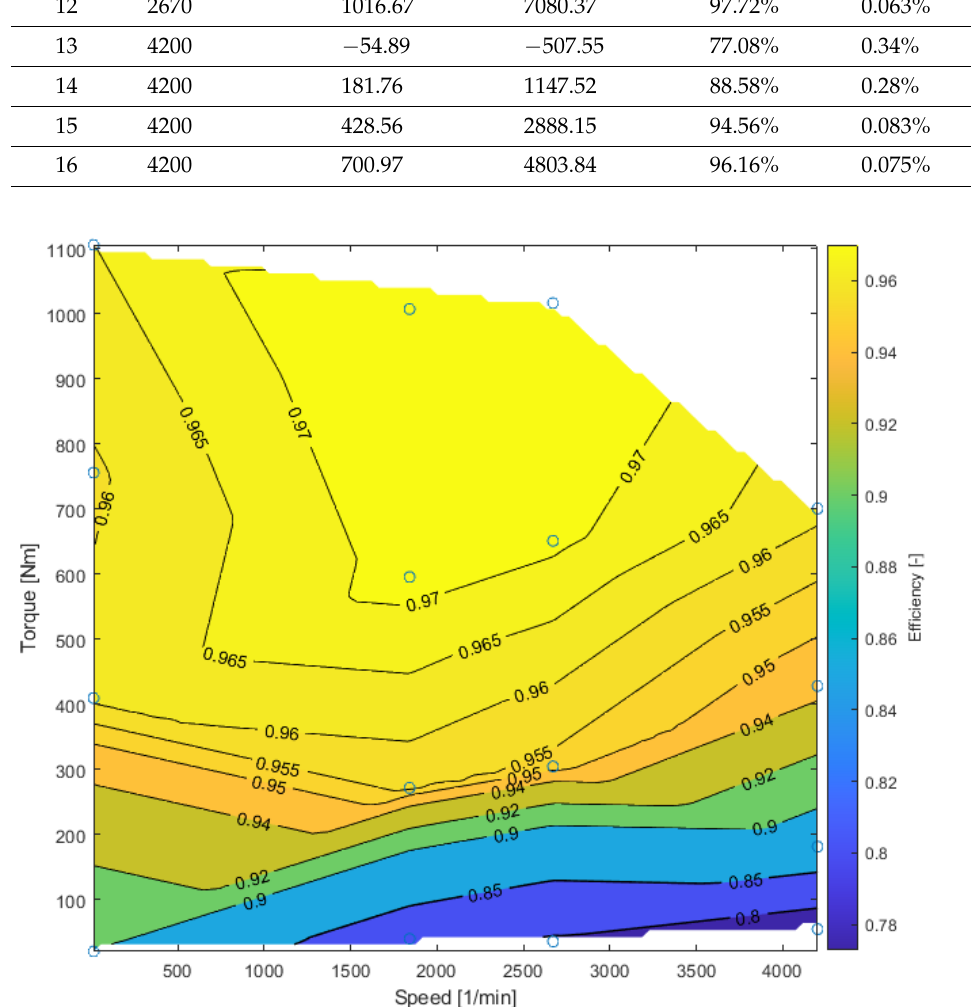
Figure 12. The efficiency map—graphical interpretation of measured